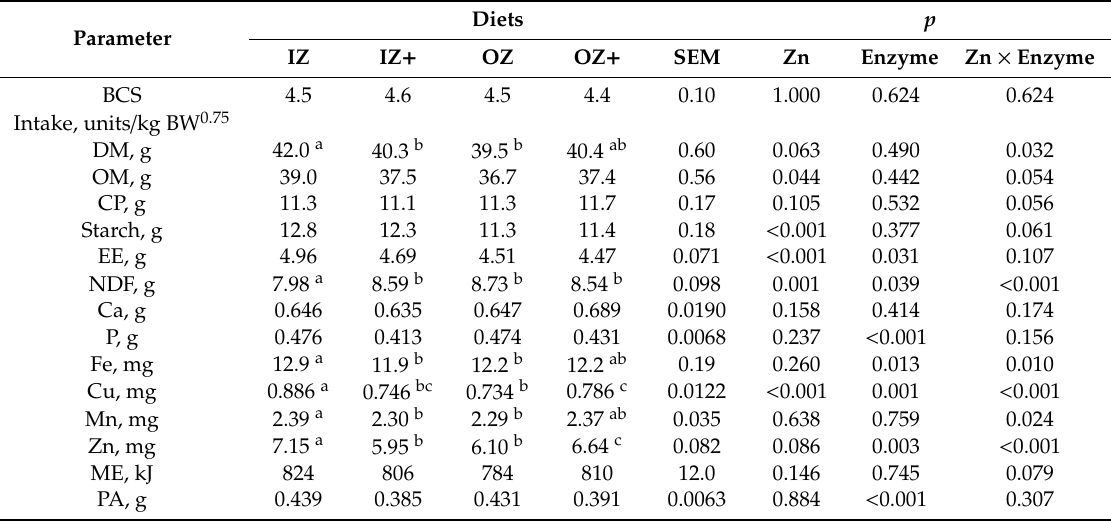
Table 4. Body condition score (BCS) and daily intake of macronutrients, minerals, metabolizable energy (ME), and phytic acid (PA) of dogs fed the experimental diets. a–c Values in the same row that share a common superscript are not statistically di ff erent ( p >